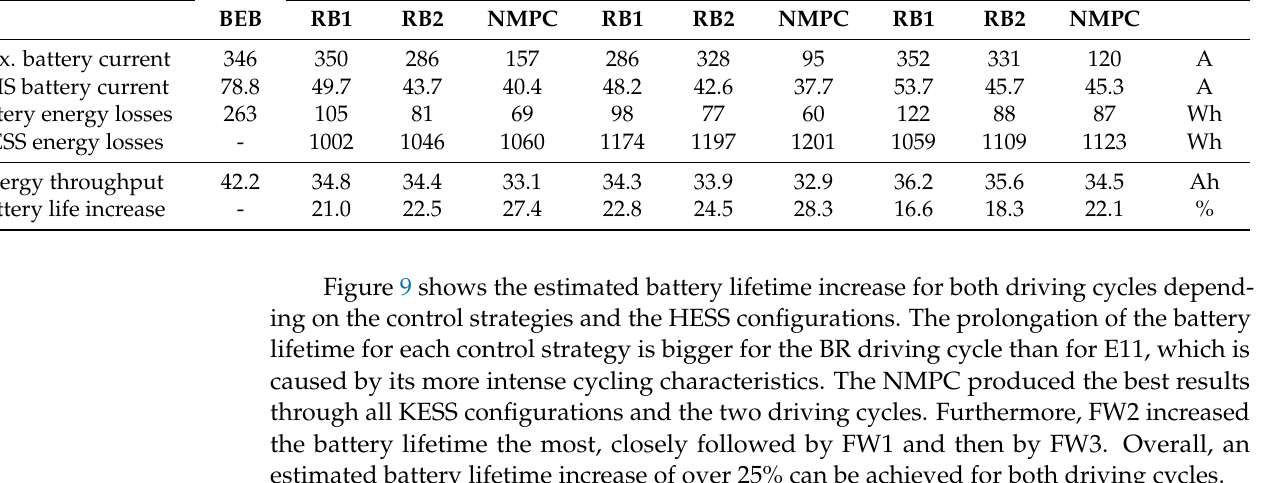
Table 7. Comparative results of the mobile KESS configurations along the BR driving cycle.